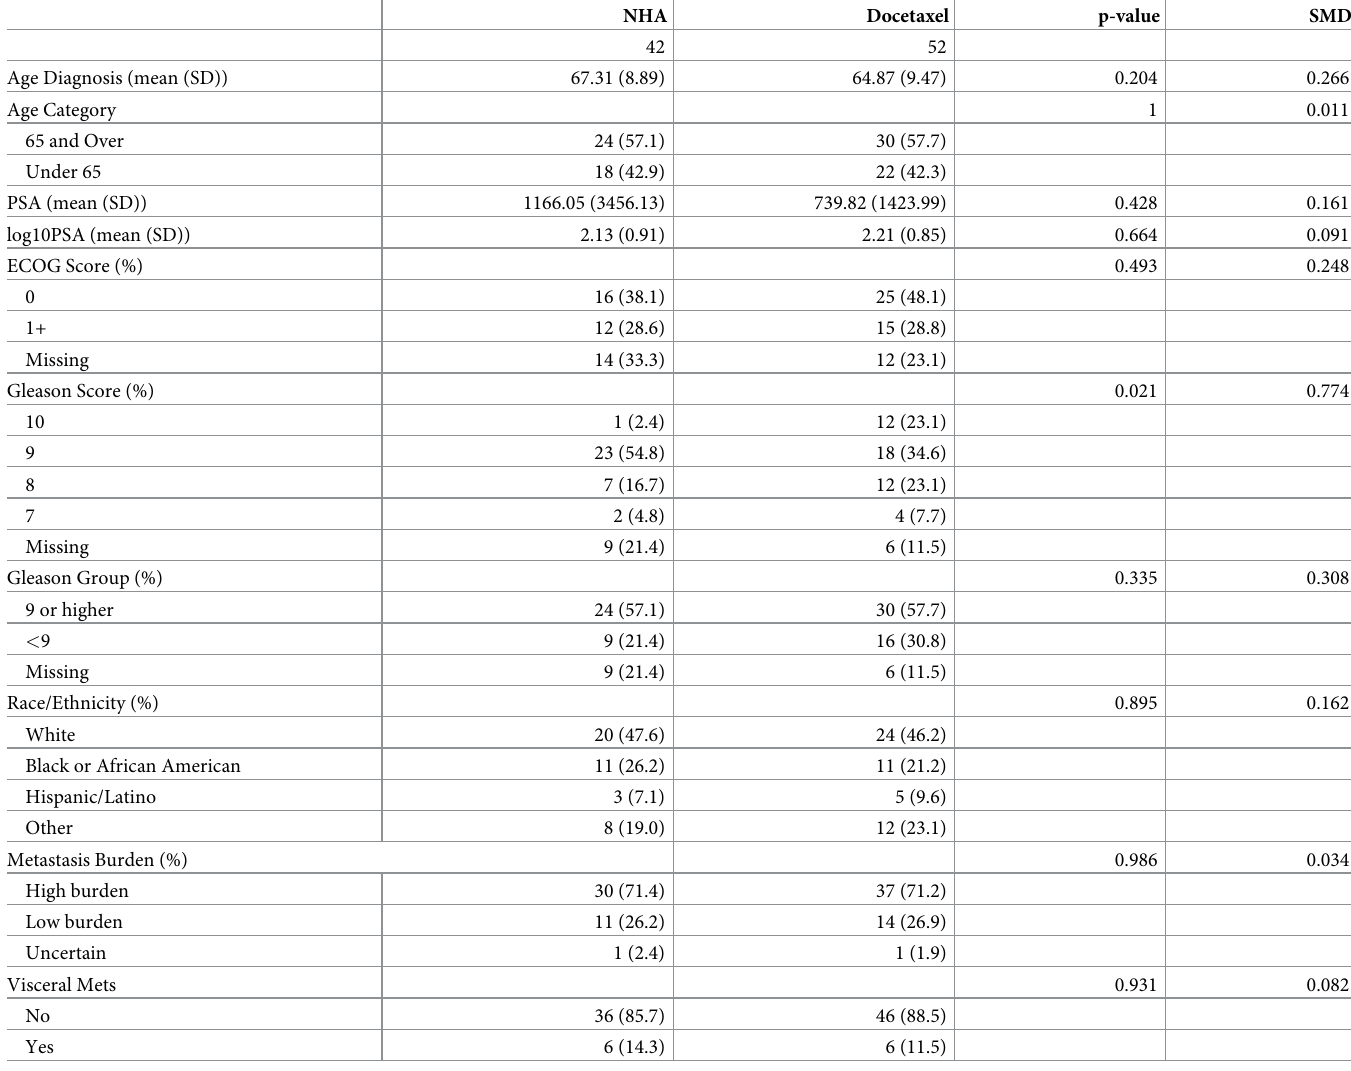
Table 1. Table of co-variants for the docetaxel and NHA